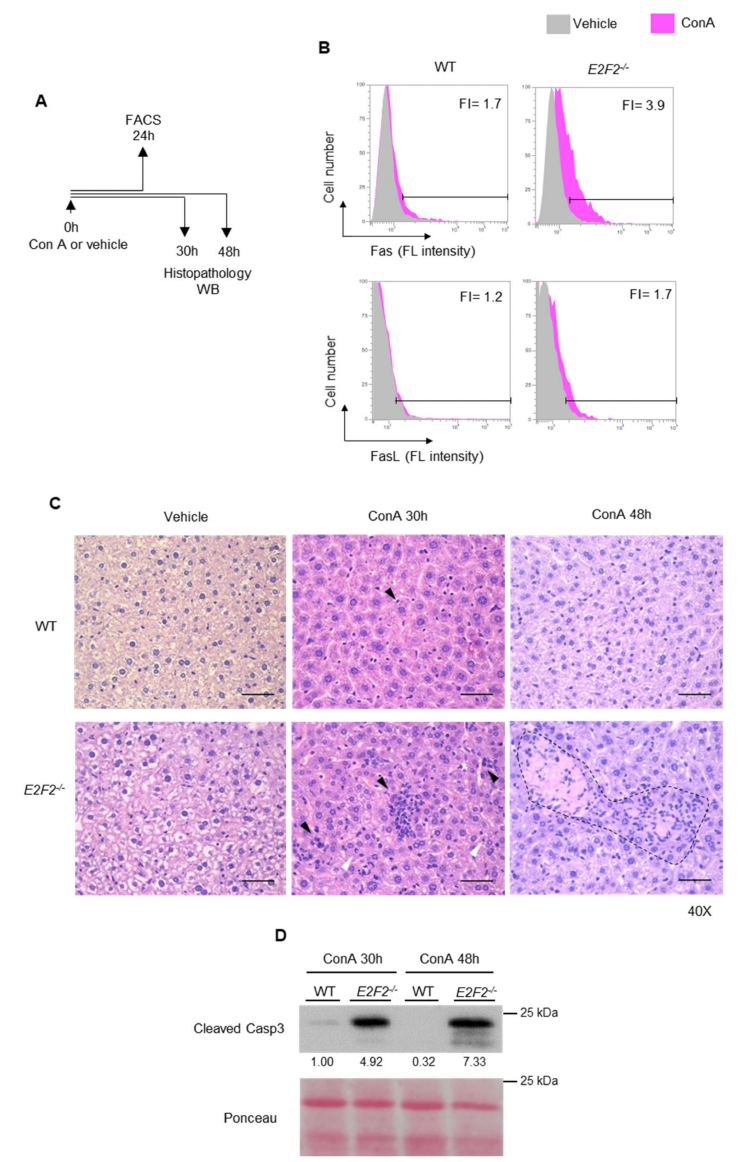
Figure 6. E2F2 loss enhances sensitivity to ConA-induced T-cell activation and immune-mediated liver injury in vivo. ( A ) Experimental set up for FACS analysis, Western blot, and histopathology after the iv injection with ConA (20 mg/kg). ( B ) Results of FACS analysis to detect surface Fas and FasL expression in cells purified from lymph nodes form WT and E2f2 − / − mice 24 h after injection with ConA (pink histogram) or vehicle control (gray histogram). X axis contains the values of fluorescence intensity (FL intensity). The results are expressed as fold increase (FI) of fluorescence intensity mean in ConA-treated samples over vehicle-treated samples. ( C ) Liver sections obtained from WT and E2f2 − / − animals 30 and 48 h after injection with ConA or vehicle control, and stained with hematoxylin/eosin (H/E, × 40, scale bar = 50 µ m). Black arrowheads indicate infiltrated inflammatory cells and white arrowheads point to shrinking nuclei of hepatocytes. Note the enhanced infiltration and enhanced necrotic area (marked with dash line) in E2f2 − / − animals after the treatment with ConA for 30 h and 48 h, respectively. ( D ) Western blot analysis of Cleaved Caspase 3 in extracts prepared from livers of WT and E2f2 − / − mice 30 and 48 h after injection with ConA. Ponceau staining was used as loading control. Numbers below the bands correspond to the relative densitometric levels expressed as fold-over WT ConA at 30